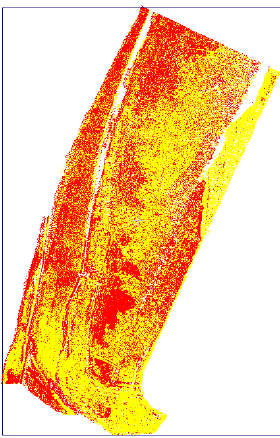
Figure 26. The result for ICP registration method – the registered point cloud data